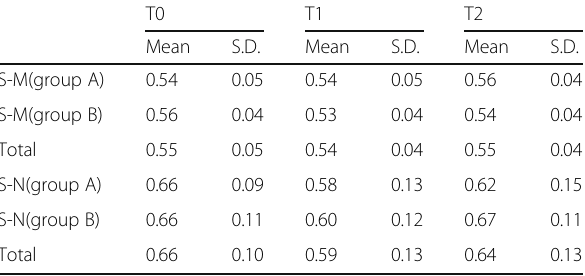
Table 3 Average position of the condyle on the sagittal